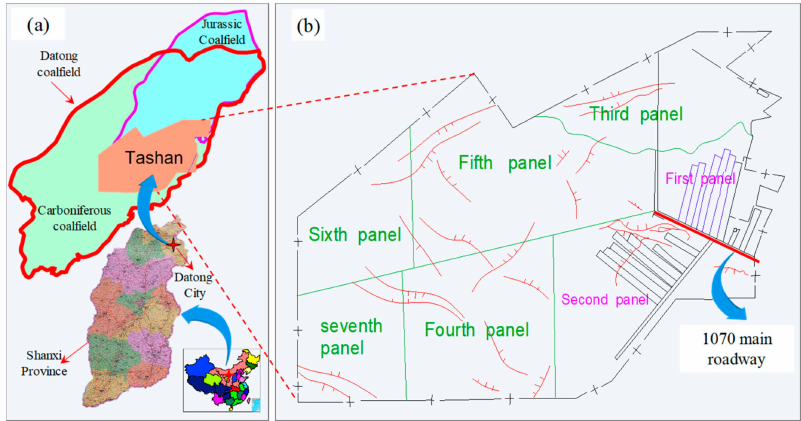
Figure 2. Location of Tashan Coal Mine and 1070 main roadway. ( a ) location of Tashan coal mine, ( b ) location of 1070 main roadway.